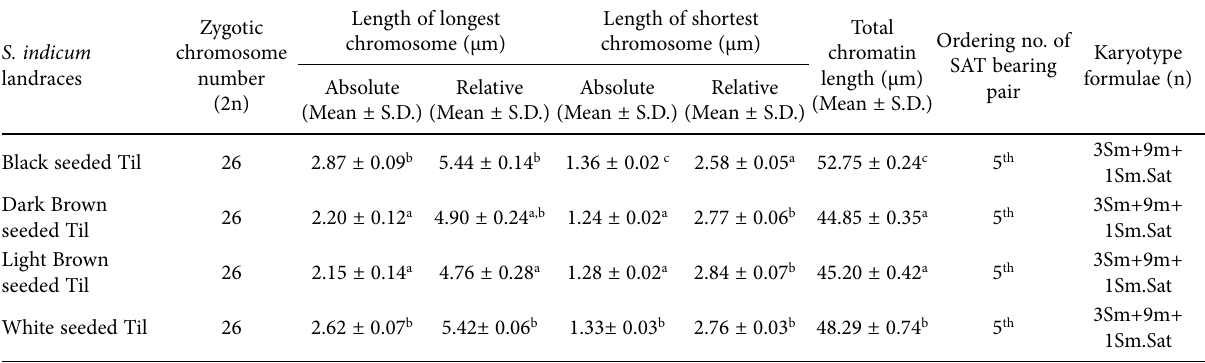
Table 1. Chromosome morphometric analysis of four Indian landraces of S. indicum *.